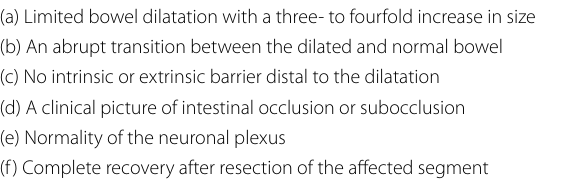
Table 1 The diagnostic criteria of segmental dilatation of the